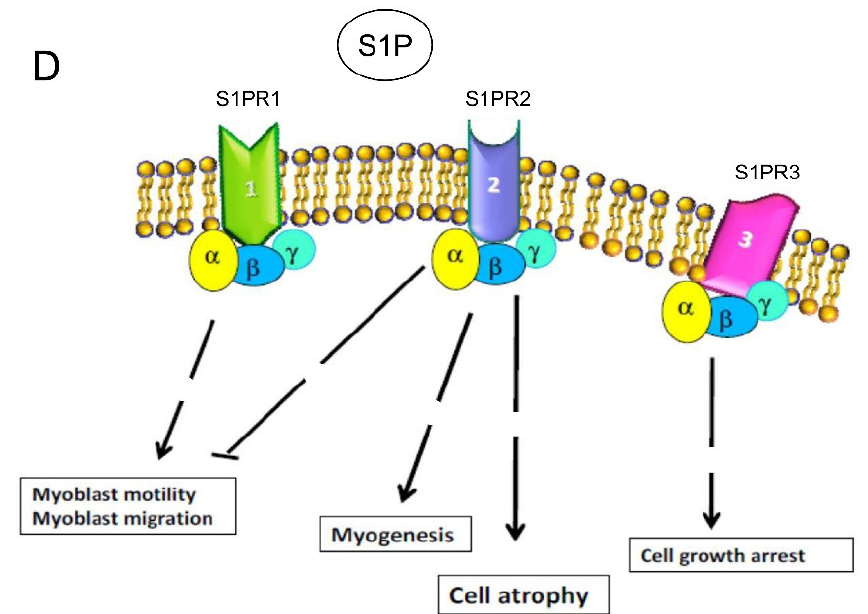
Figure 1. Sphingolipid metabolism and sphingosine-1-phosphate (Sphingosine 1-P) signaling. ( A ) General sphingolipid structure. Sphingolipids are composed of a sphingosine backbone linked to a fatty acid. ( B ) Sphingomyelin cycle or de novo sphingolipid synthesis leading to ceramide involving serine palmitoyl transferase (SPT), 3-keto dihydrosphingosine reductase (KDHSR), ce- ramide synthase (CERS), and desaturase (DES). Ceramide is converted reversibly to sphingosine by ceramidase (CDase) or phosphorylated to ceramide-1-phosphate (Ceramide 1-P) by ceramide kinase (CerK) activity and dephosphorylated by ceramide-1P phosphatase (C1PP). S1P is synthesized from sphingosine by the sphingosine kinases (SphK) and irreversibly cleaved by S1P lyase (SPL), which generates hexadecenal and phosphoethanolamine (ethanolamine -P). S1P is also a substrate of specific S1P phosphatases (S1PP) or lipid phosphate phosphohydrolase (LPP). Sphingomyelin synthases (SMS) transfer a phosphorylcholine group from phosphatidylcholine to ceramide, gen- erating diacylglycerol and sphingomyelin. Sphingomyelinases (SMase) catalyze the hydrolysis of sphingomyelin, leading to the generation of ceramide and phosphorylcholine. ( C ) S1P produced inside the cell can be transported in the intercellular space by an ATP-binding cassette transporter named spinster homolog 2 (Spns2). ( D ) As a ligand, S1P acts as autocrine and paracrine factors triggering specific signaling pathways by interacting with S1P specific heterotrimeric GTP binding protein-coupled receptors, named S1PR. Three among five subtypes of S1PRs, S1PR-1, -2, and -3, are expressed in skeletal muscle cells and regulate through different steps (broken lines) specific biological functions. The scheme exemplifies the main roles played by S1PR activation in skeletal muscle